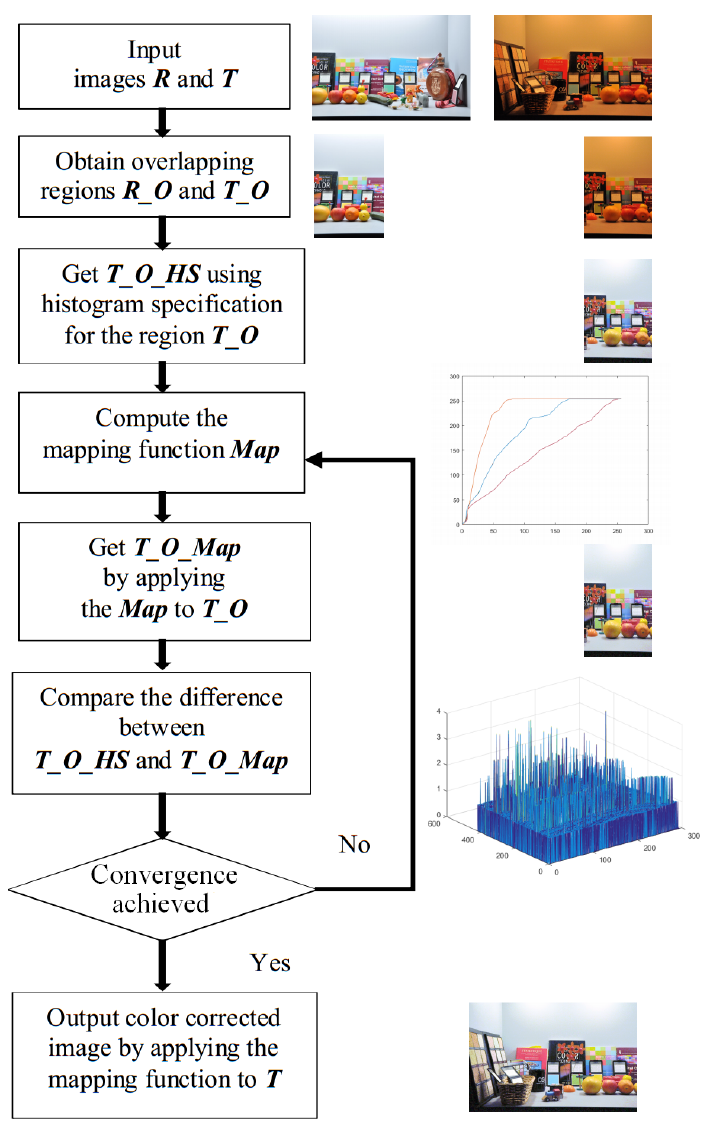
Figure 2. The framework of the proposed algorithm. Image Source: courtesy of the authors and databases referred on